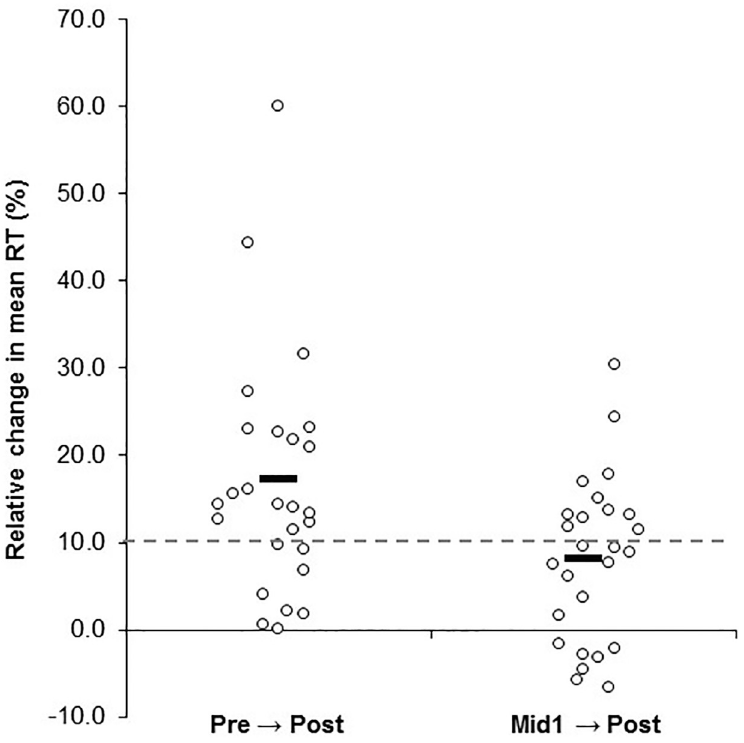
Fig 2. Individual scatter plot showing the relative (%) change scores for mean reaction time (RT) for each participant from baseline (Pre) to after the three consecutive work shifts (Post), and from the end of the first work shift (Mid1) to the end of the third shift (Post). Note, positive % change indicates poorer RT performance (i.e., an elongated response time versus earlier time trial). Horizontal dashed line represents a 10% reduced performance and is used here as an illustration of a hypothetical threshold where such a performance impairment may begin to negatively impact on-the-job task performance.